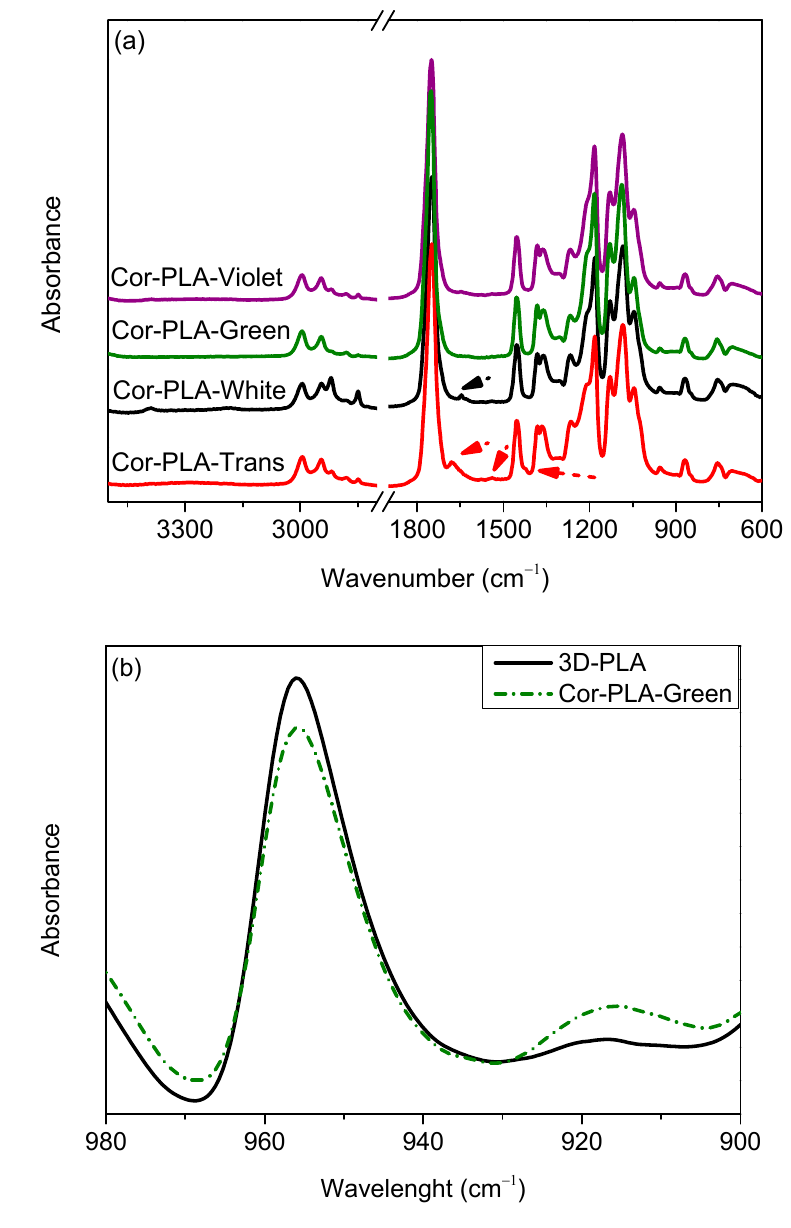
Figure 3. FTIR ‐ ATR spectra ( a ) of the components of the 3D printing waste mixture, ( b ) 980–900 cm ‐ 1 of the FTIR spectra of 3D printing wastes. of the FTIR spectra of 3D printing